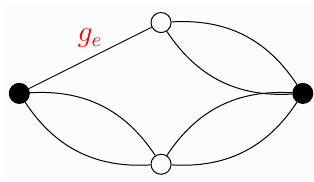
Figure 13 . A further generalization of figure 11. Every link e represents a coupling of two T N theories by a superpotential of the form (3.20), corresponding to a g ∈ SL(2 , Z ) as in (3.17).